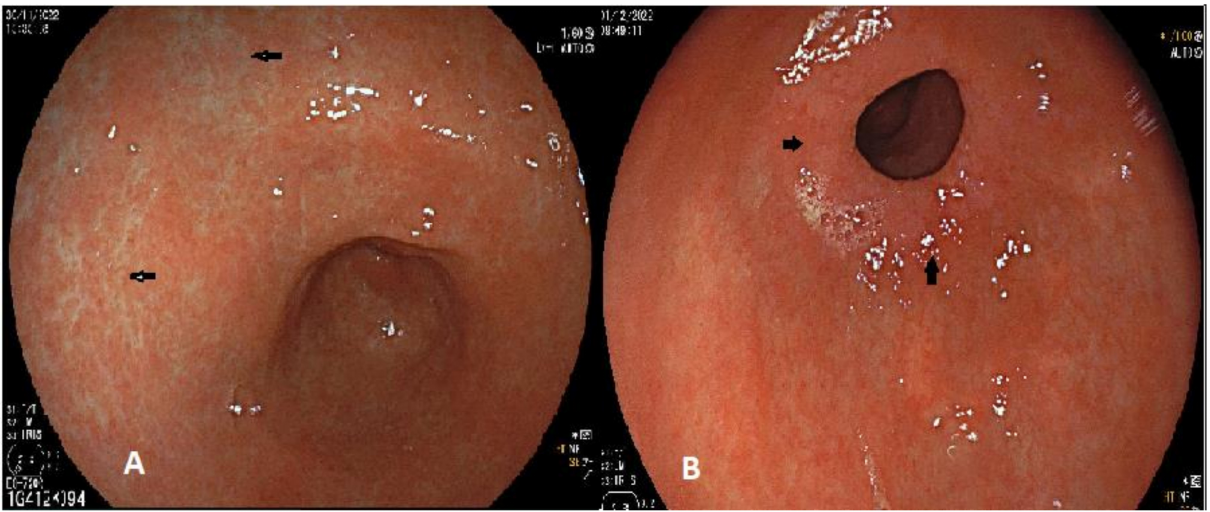
Figure 1. Gastric antrum with atrophic mucosa ( A ) and with IM, visible as whitish lesions surrounding the pylorus ( B ). Arrows indicate the areas with more atrophy ( A ) and the areas with IM ( B ),